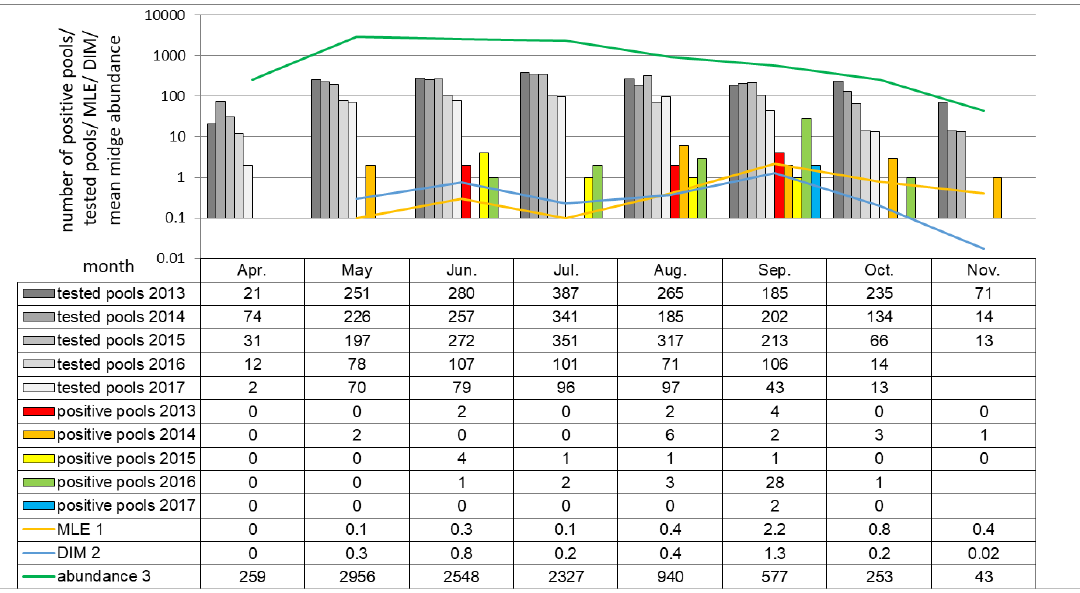
Figure 5. Monthly distribution of SBV RNA positive pools in all tested seasons (no pools were tested in November in 2016 and 2017). The shades of grey and colored columns represent the numbers of tested pools and SBV positive midge pools in respective year. The green curve represents the average number of individual midges caught in month intervals between 2013 and 2017 indicating the dynamic of midge month abundance over the course of the study. Similarly, the MLE and virus infected midges (DIM) dynamics are presented as yellow and blue curves, respectively. The original numeric data are placed below in the table. 1 MLE (Maximum likelihood estimation) calculated for 2013–2017; 2 DIM (Density of infected midges) calculated as proportion of mean abundance multiplied by MLE per 1000 individuals; 3 Abundance (Mean midge abundance per single catch) sum of midges trapped in consecutive month in 2013–2017 divided by number of catches in respective month.